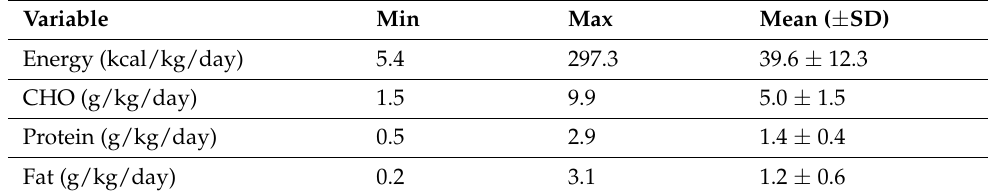
Table 4. Energy and macronutrients intake of